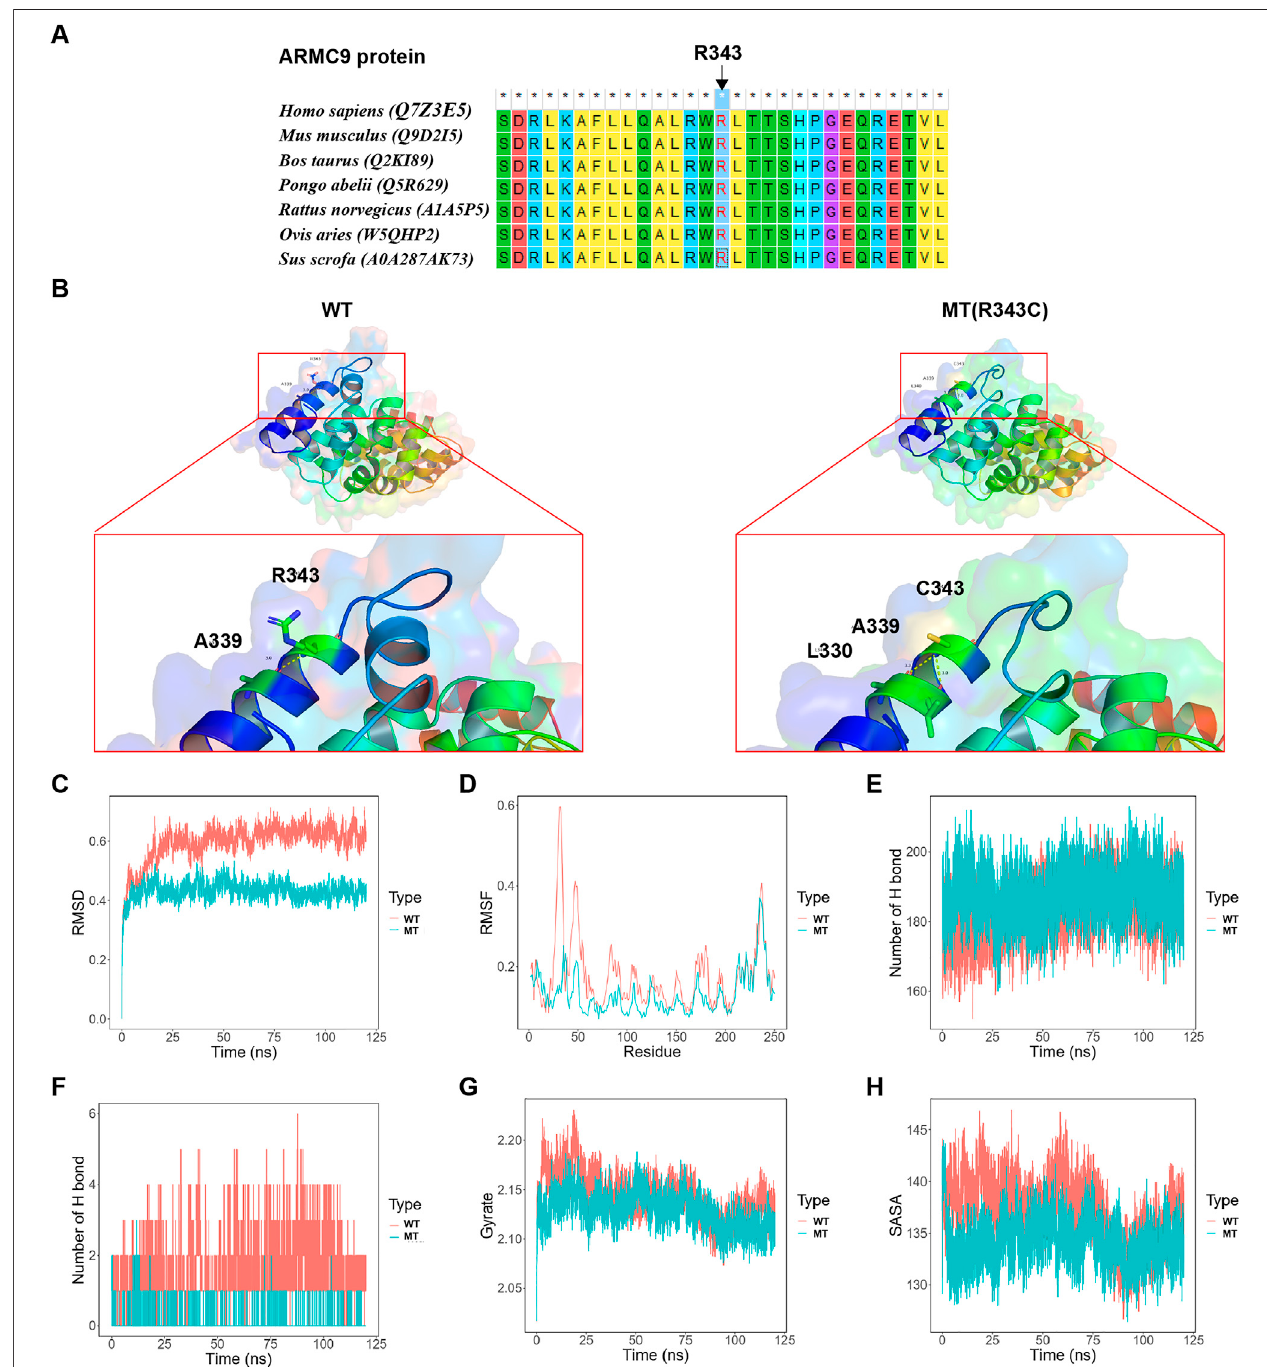
FIGURE 3 | Analysis results on the c.1027C > T: p. Arg343Cys variant. (A) The conservation of ARMC9: Arg343 residue across species. (B) The structures of the domaincontainingtheWTandArg343Cysmodels(residuesforminghydrogenbondswiththeresidueArg343orArg343Cysaredepictedinstickrepresentation;dotted yellowlines represent the hydrogen bonds). (C) The trajectory of RMSD (Ca) for the two proteins, which compared every structure in the trajectory tothe reference/initial frame (0 ns) by computing the root mean square deviation (RMSD). RMSD is a numerical measurement representing the difference between two structures. In molecular dynamics, we are interested in how structures and parts of structures change over time as compared to the starting point, so the trajectory of RMSD can be used toidentify large changesinprotein structure ascomparedtothestartingpoint. (D) RMSF ofthetwoproteins calculated fromeach simulation,whichcomputedthe root mean square fl uctuation (RMSF) of atomic positions in the trajectory after fi tting to the reference/initial frame (0 ns). RMSF is a numerical measurement similar to RMSD, but instead ofindicating positional differences between entire structures over time, RMSF isa calculation ofindividual residue fl exibility, or how much a particular residue moves ( fl uctuates) during a simulation. (E) The number of hydrogen bonds formed in the wild-type or mutated protein. Although the hydrogen bond is much